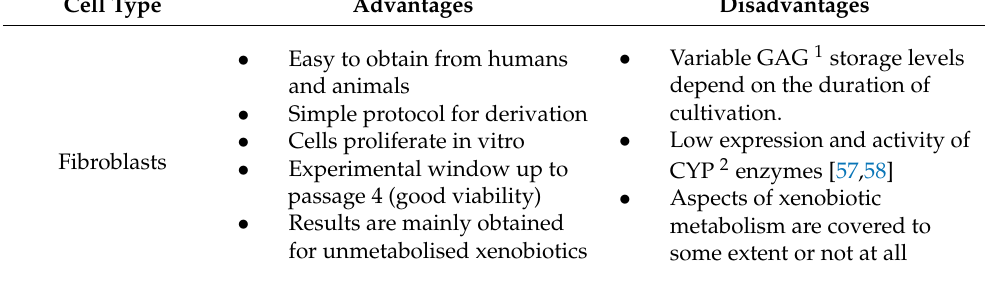
Table 2. Summary of advantages and disadvantages of fibroblasts and hepatocytes as a model for studying the pathophysiology of mucopolysaccharidosis I (MPS I) and testing potential therapeutics. Cell